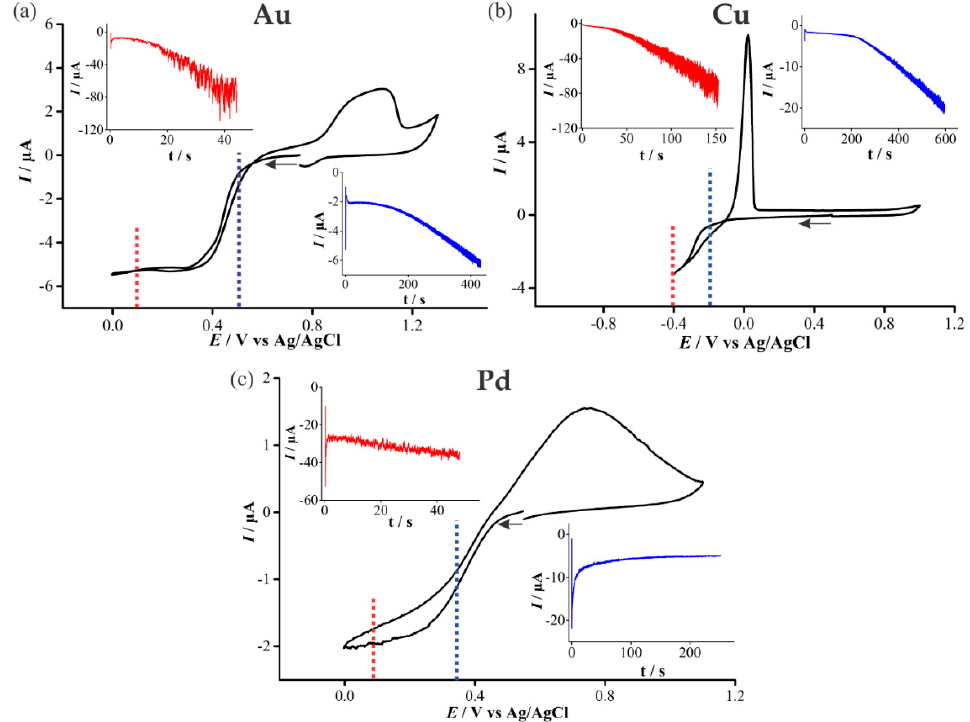
Figure 3. Cyclic voltammetry (CV) at 100 mVs − 1 on a recessed Pt microarray thin-film electrode (MATFE) (90 holes, 10 µm in diameter) in ( a ) 20 mM N 2 -saturated HAuCl 4 in 0.5 M H 2 SO 4 , ( b ) 20 mM N 2 -saturated Cu(NO 3 ) 2 in 0.5 M NaNO 3 , ( c ) 20 mM N 2 -saturated PdCl 2 in 0.5 M H 2 SO 4 . The insets show the chronoamperometric transients for the deposition of Au, Pd and Cu at an overpotential and an underpotential into the microholes, held at the potentials indicated by the dotted lines in the CV.